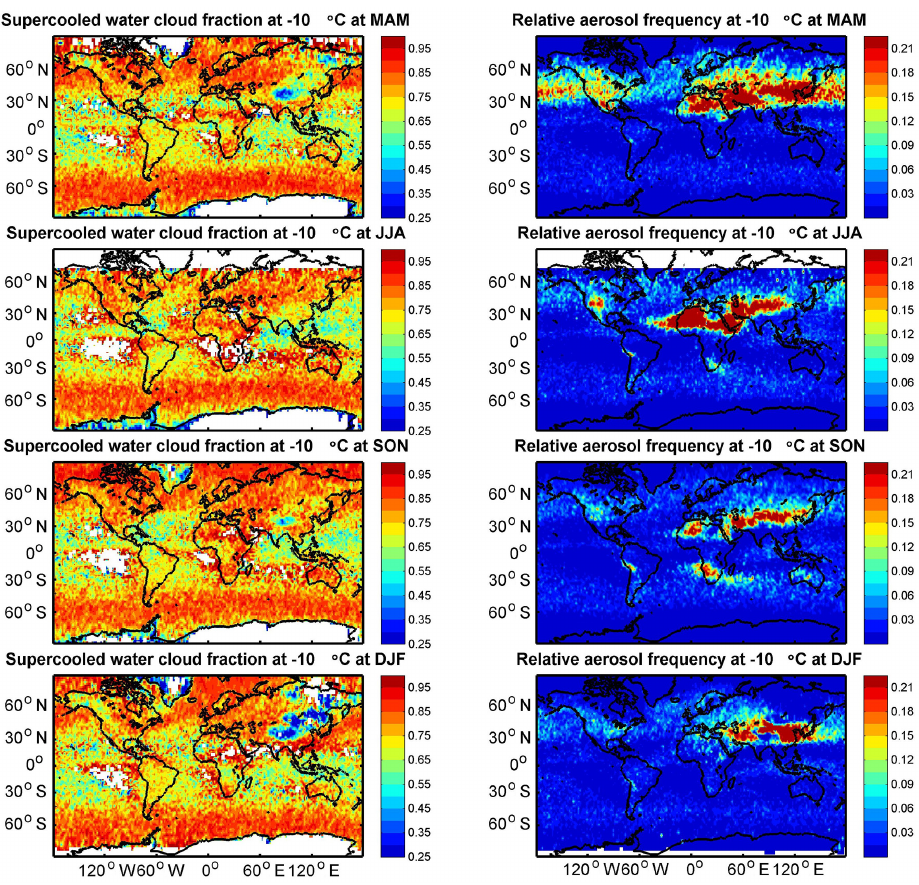
Figure 1. The global and seasonal variations of supercooled water cloud fractions (SCFs) and relative aerosol frequencies (RAFs) during nighttime at − 10 ◦ C isotherm over 2 ◦ × 2 ◦ grid